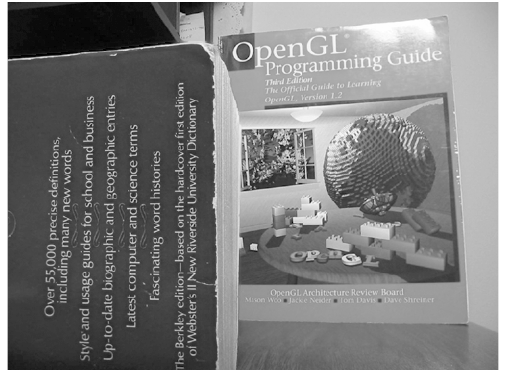
Figure 8. Final fused image by the proposed